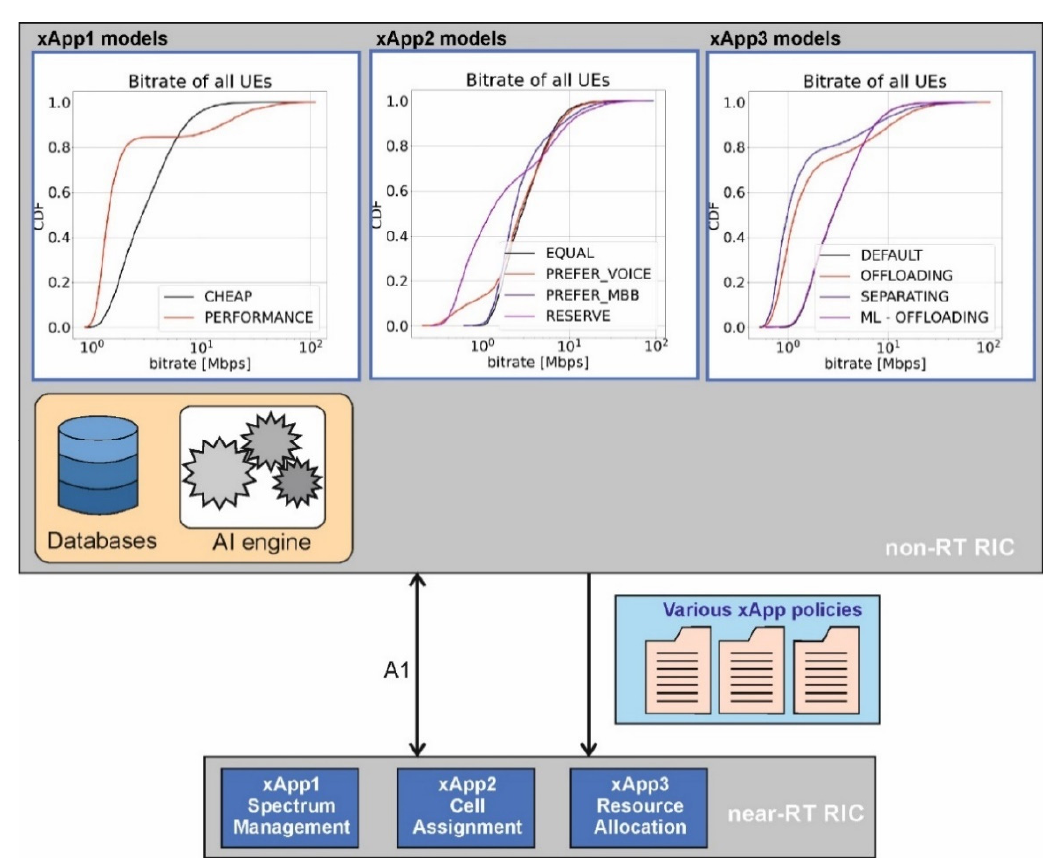
Figure 3. Mapping of xApps installations to RICs (xApp1—Spectrum Management, xApp2—Cell Assignment, xApp3— Resource Allocation).